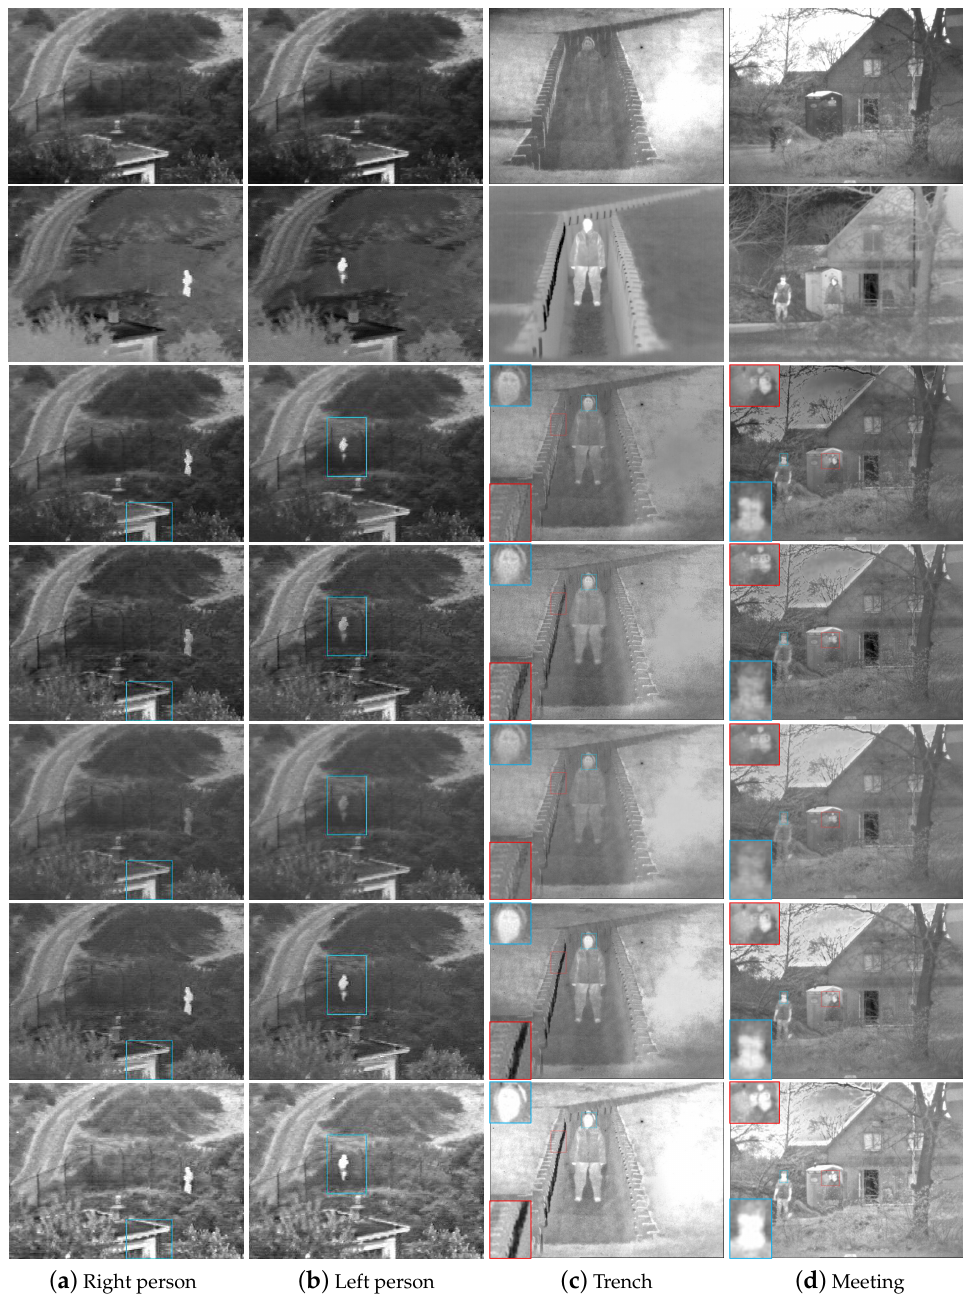
Figure 8. Fusion results on four typical panchromatic VIS and IR images. From top to bottom: the VIS images, the IR images, the fused images of our method, ADF [32], Bayesian [34], MLGCF [27], and GFCE